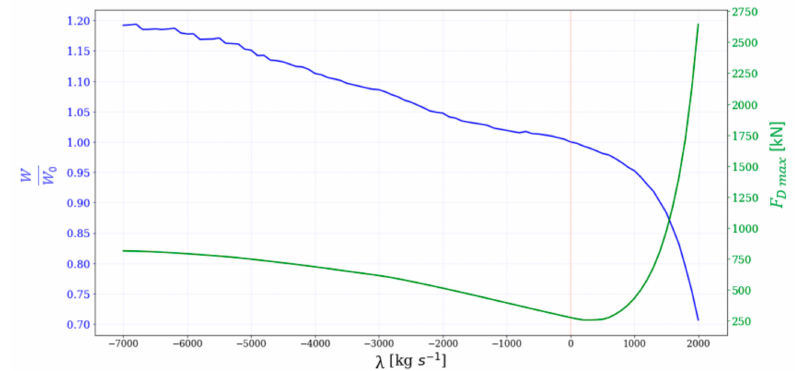
Figure 3. Final energy of the rocket ( W ) in model flight divided by real final energy of the rocket ( W / W 0 ) as a function of λ (blue curve). The maximum resistance force to a rocket ( F D max ) in flight simulation as a function of λ (green